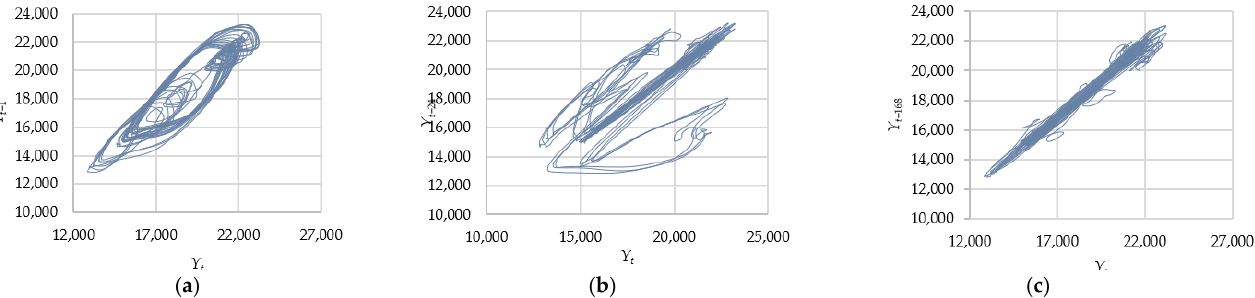
Figure 5. Attractors of the time series of load data in two-dimensional phase-spaces: ( a ) ( Y t , Y t − 1 ), ( b ) ( Y t , Y t − 24 ), and ( c ) ( Y t , Y t − 168 ).